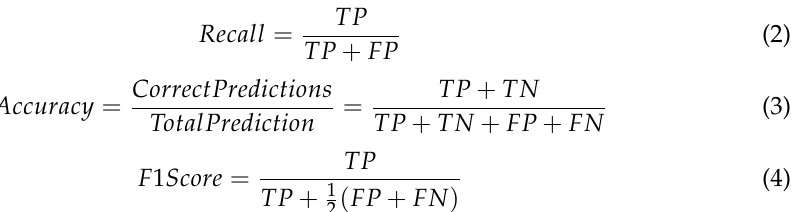
Table 2. Press classification results.